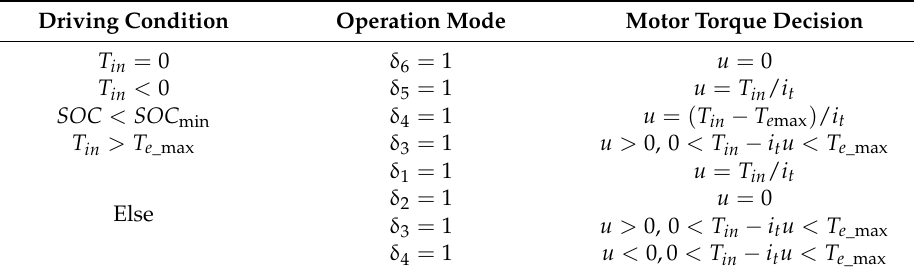
Table 5. Heuristic